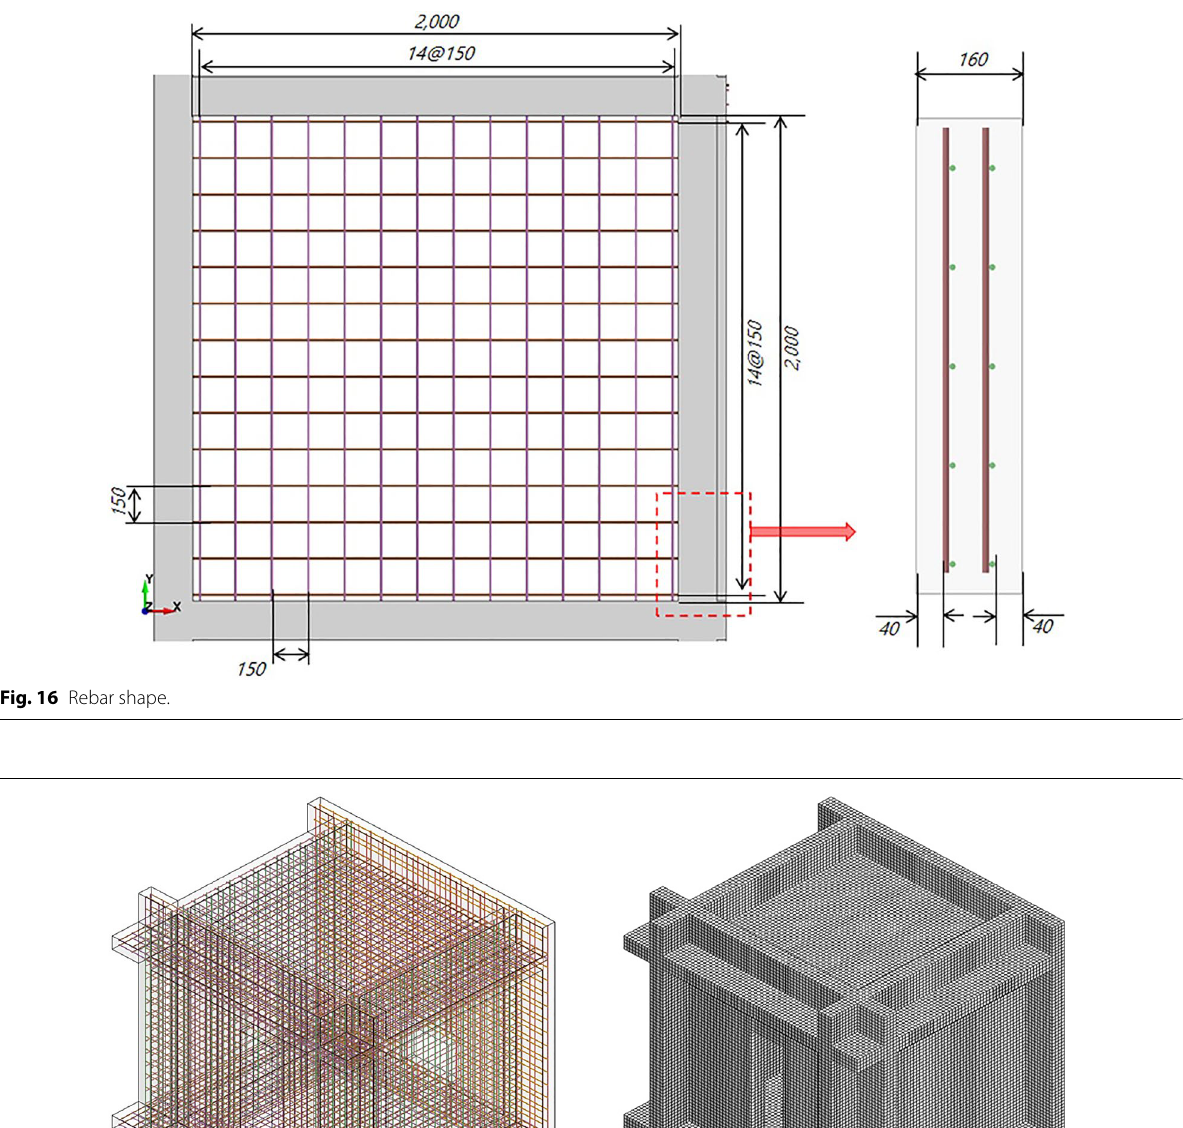
Fig. 17 Element model of the reinforced concrete